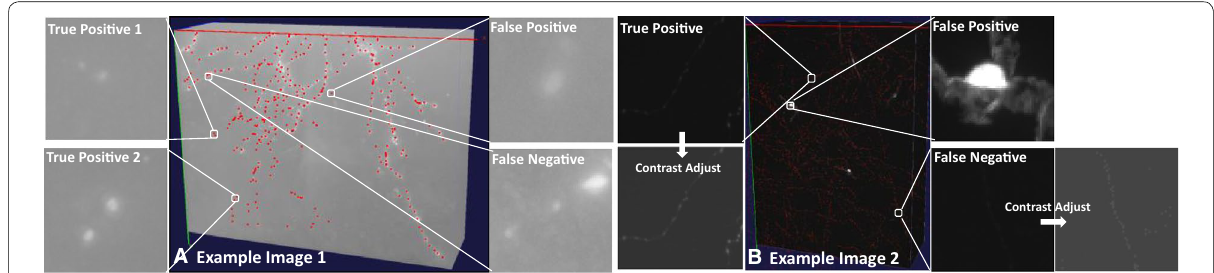
Fig. 3 Axon detection results on two challenging datasets. ( a ) An example of a 3D image stack of mouse neuron imaged with bright‑field microscopy (also see Fig. 2a). ( b ) An example of a 3D stack (shown as cropped) from a whole mouse brain imaged with fMOST; the pixel resolution is 0.3 um 0.3 um 1 um. Red dots indicate detected axonal signals. The two false positive example patches shown in ( a ) and ( b ) could be × × eliminated with more training samples. Those false negative patches (also as shown in ( a ) and ( b )) with very weak signals at the center could be further identified by increasing the amount of weak signal foreground samples in the training